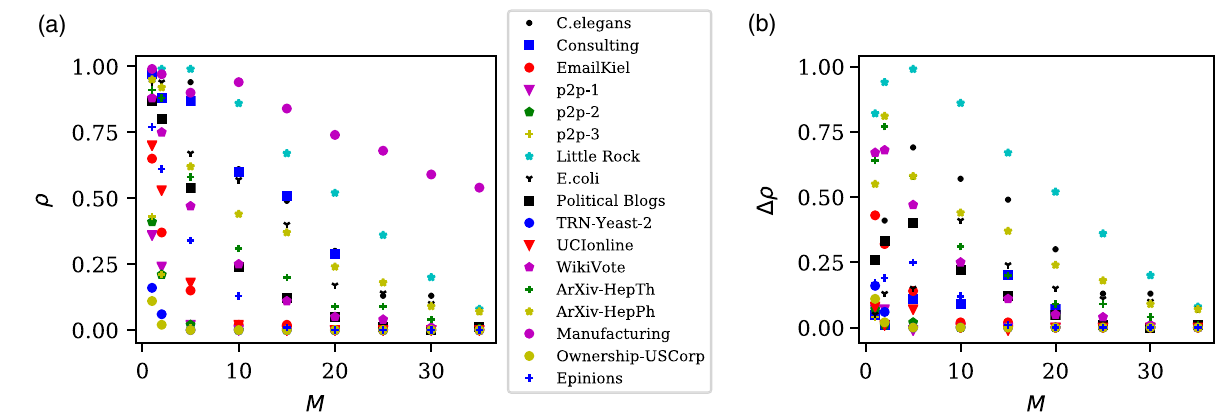
FIG. 11. The sensor node placement algorithm can increase the probability of invertibility ρ if the input node set is given (scenario SC II). (a) The input node set is again uniformly sampled. All other nodes are considered as potential maximum output node set Z 0 . In the case of invertibility, the sensor node placement algorithm can reduce Z 0 to a minimum sensor node set Z (cid:5) with P (cid:5) ¼ M outputs. (b) The difference Δ ρ between the probability of invertibility ρ in (a) and the uniform random selection scheme used in Fig. 9(a) to highlight the improvement.